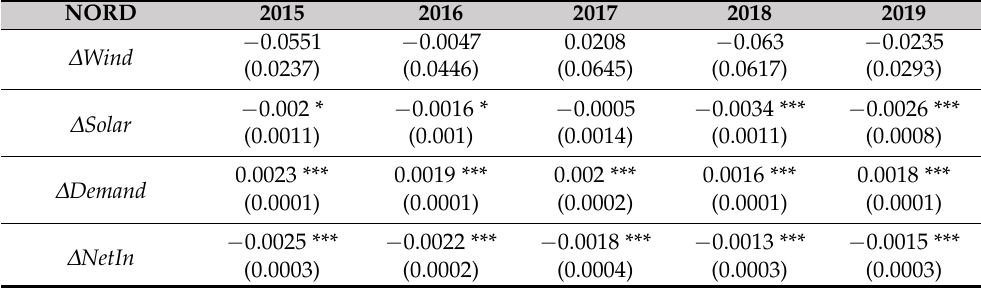
Table A15. OLS estimation of daily changes in electricity prices of NORD; results of Equation